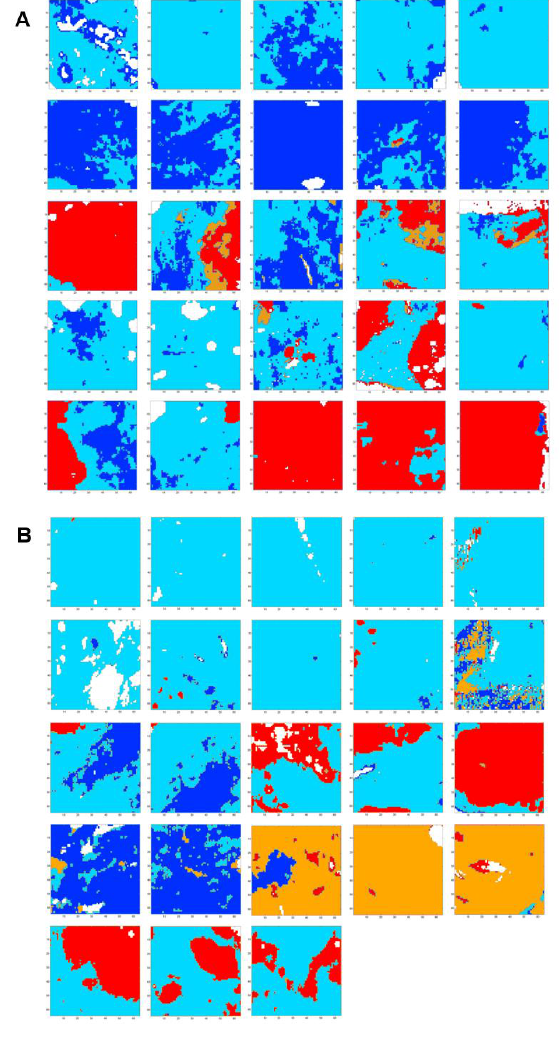
Figure 6. FTIR spectral images of 48 fibrosis areas (172.8 × 172.8 µm 2 ) recorded from five samples of uncomplicated cirrhosis (panel ( A ): 25 images) and five samples of cirrhosis with HCC (panel ( B ): 23 images) clustered in four classes in the spectral range 1040–1425 cm −1 . Results are from FTIR images acquired with a projected pixel size of 2.7 μm .